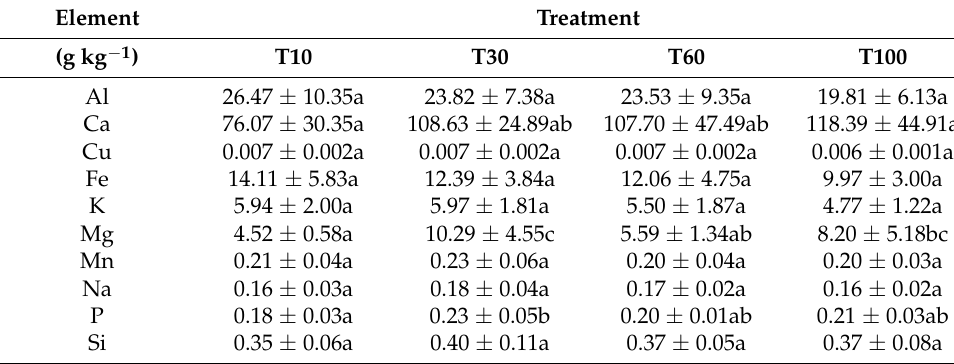
Table A1. Mean ± standard deviation values for selected soil elements. Lower case letters denote